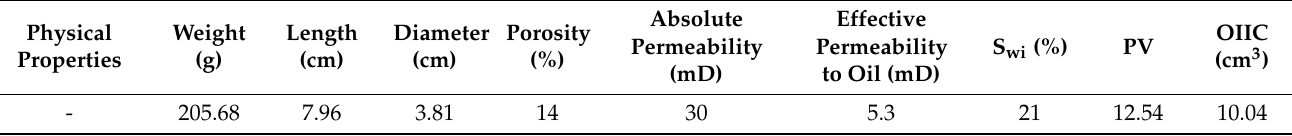
Figure 3. Image of rock sample, taken using a Crossbeam 540 SEM. Table 1. Dimensions and physical properties of the core plug.